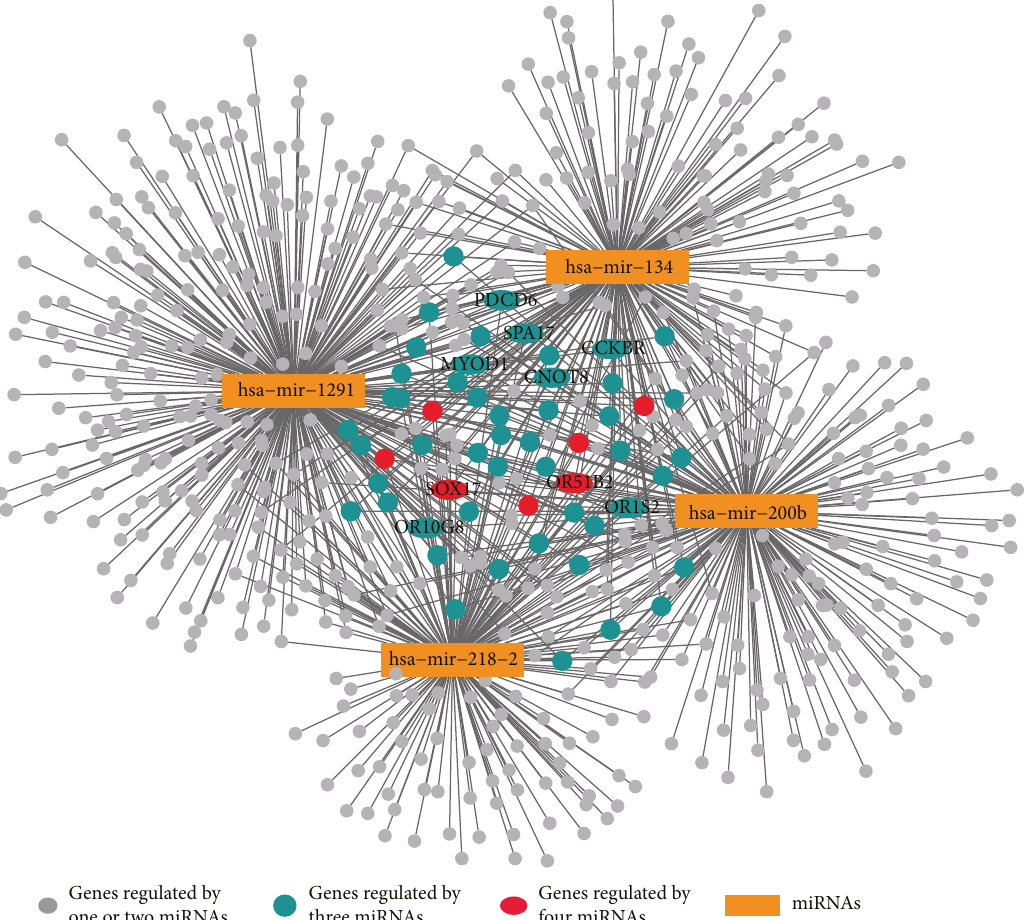
Figure 4: The miRNA-mRNA interaction subnetwork in KIRC. The four miRNAs in the network were reported to be associated with AML. In the fi gure, 49 mRNAs (cyan dots) and 7 mRNAs (red dots) were predicted to be connected with three and four miRNAs, respectively. The genes correlated with cancers were marked with their gene symbols.